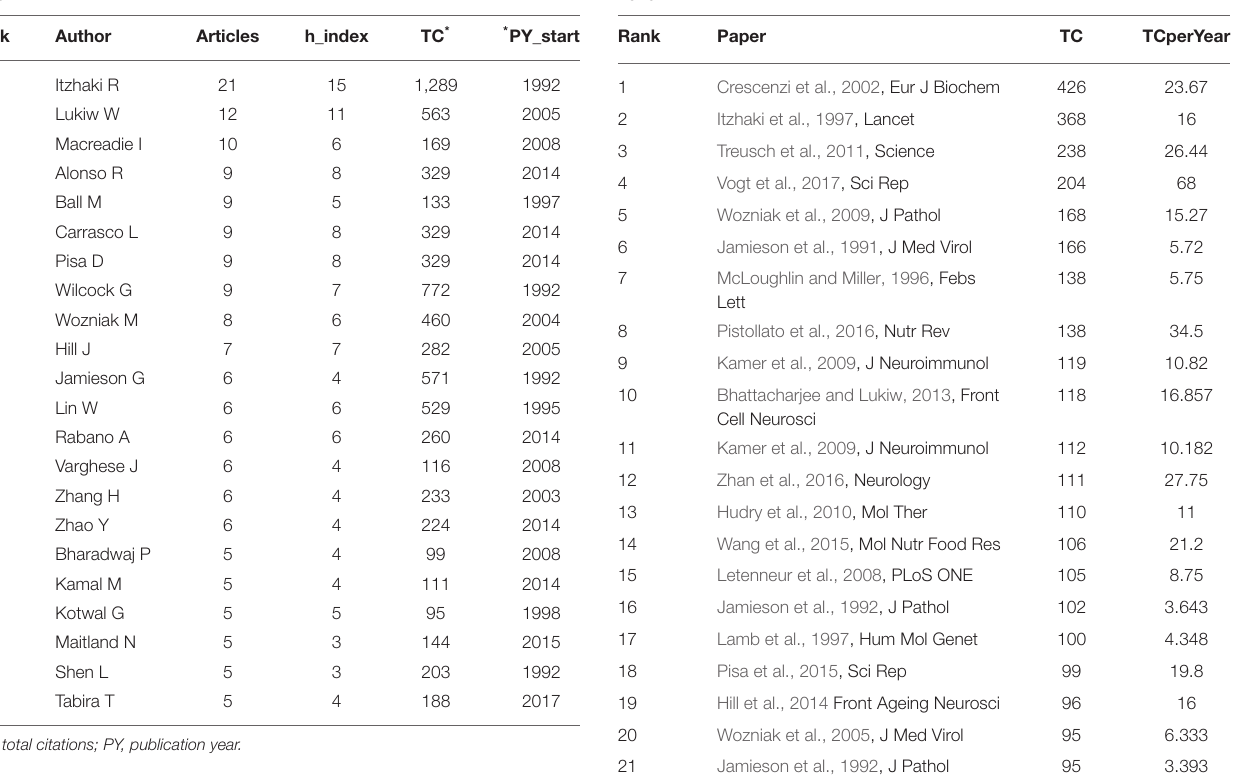
TABLE 3 | Top most cited papers on MPP-AD related research from 1982 to